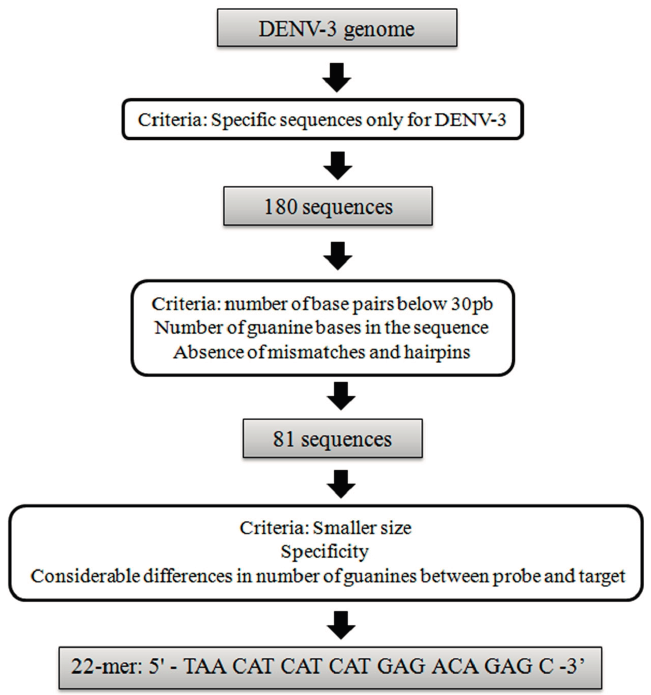
Figure 1. Flowchart of the selection criteria used to design the DENV-3